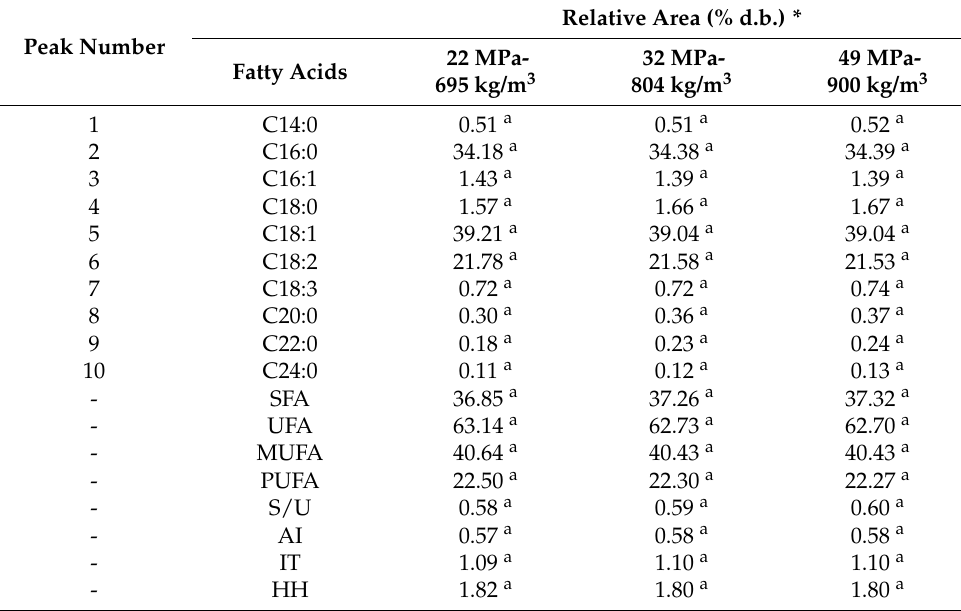
Table 2. Total fatty acids and functional potential of the oils of murici pulp ( B. crassifolia ) obtained by CO 2 -SFE at 343.15